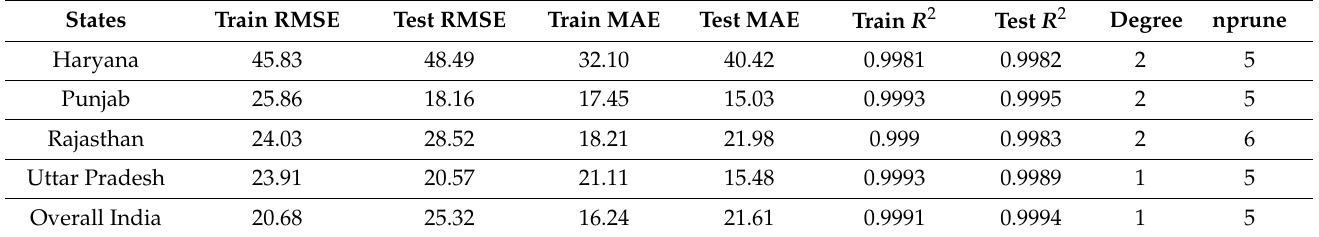
Table 10. Error validation and parameter values of training and testing datasets by using MARS for the wheat yield